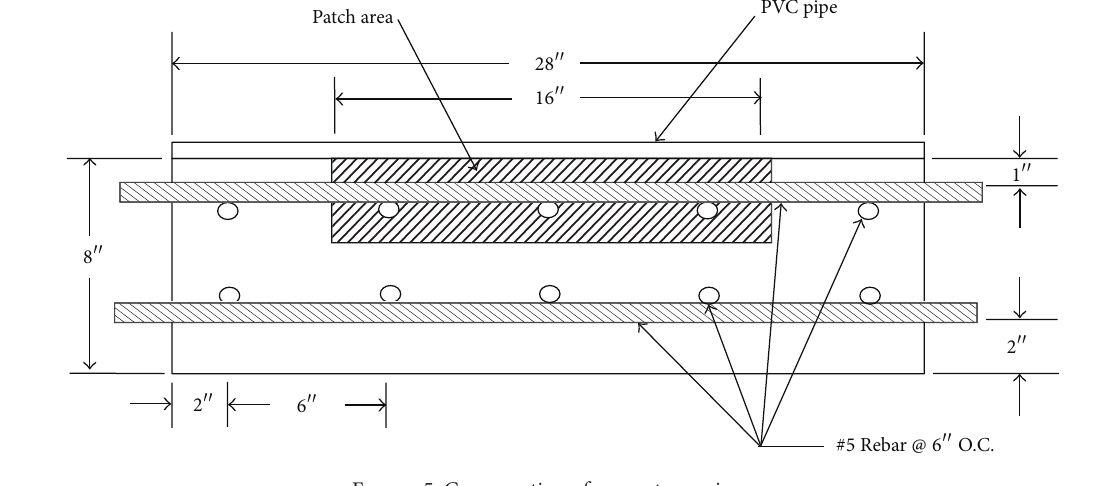
Figure 5: Cross-section of concrete specimens. Table 2: Table of treatments used for each specimen ∗